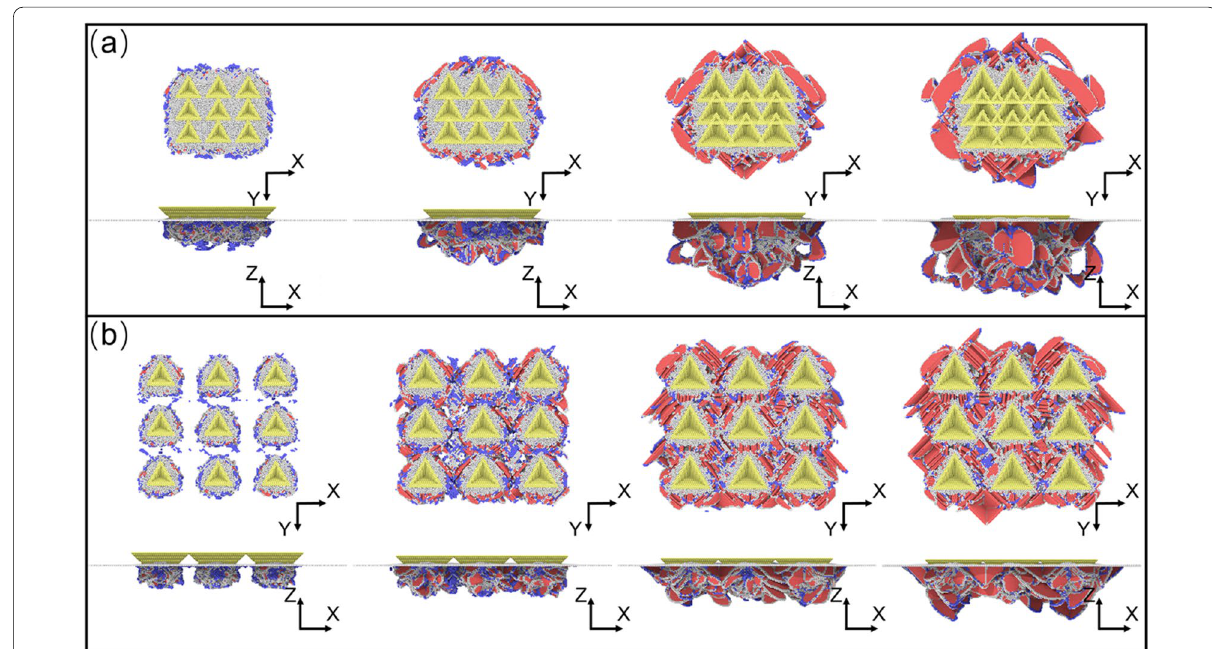
Fig. 8 Dislocation structures generated in Indenters-array indentation process a CNA snapshots with the spacing of 5 nm, b CNA snapshots with the spacing of 10